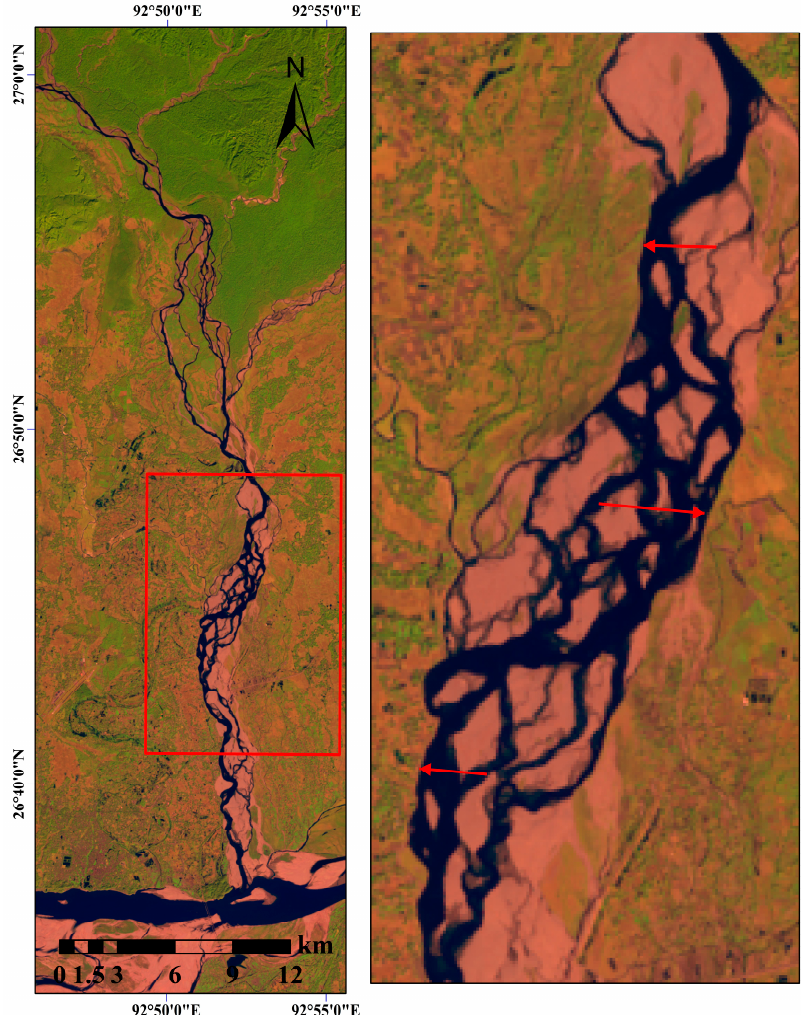
Figure 13. The thalweg approaches the bank after being deflected by several sandbars in Jia Bharali River